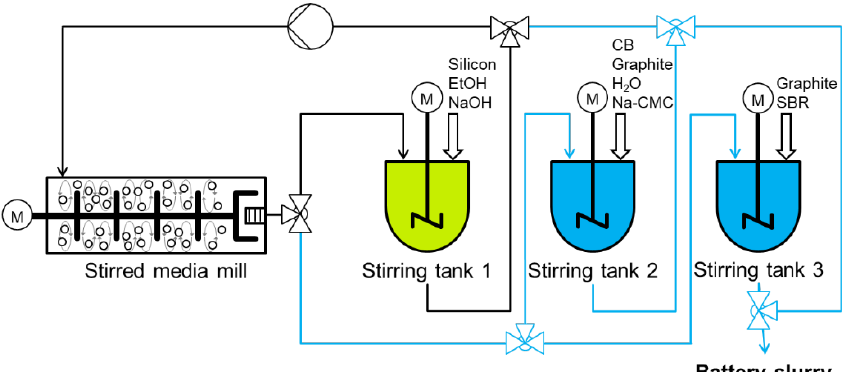
Figure 4. Setup for the sequential grinding of the mixture components for the production of a battery slurry.